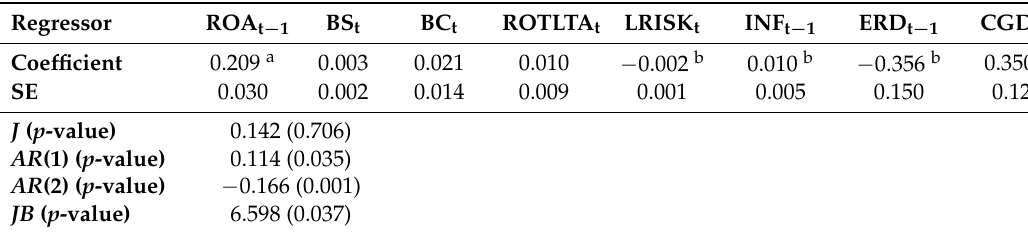
Table 7. GMM estimation results with